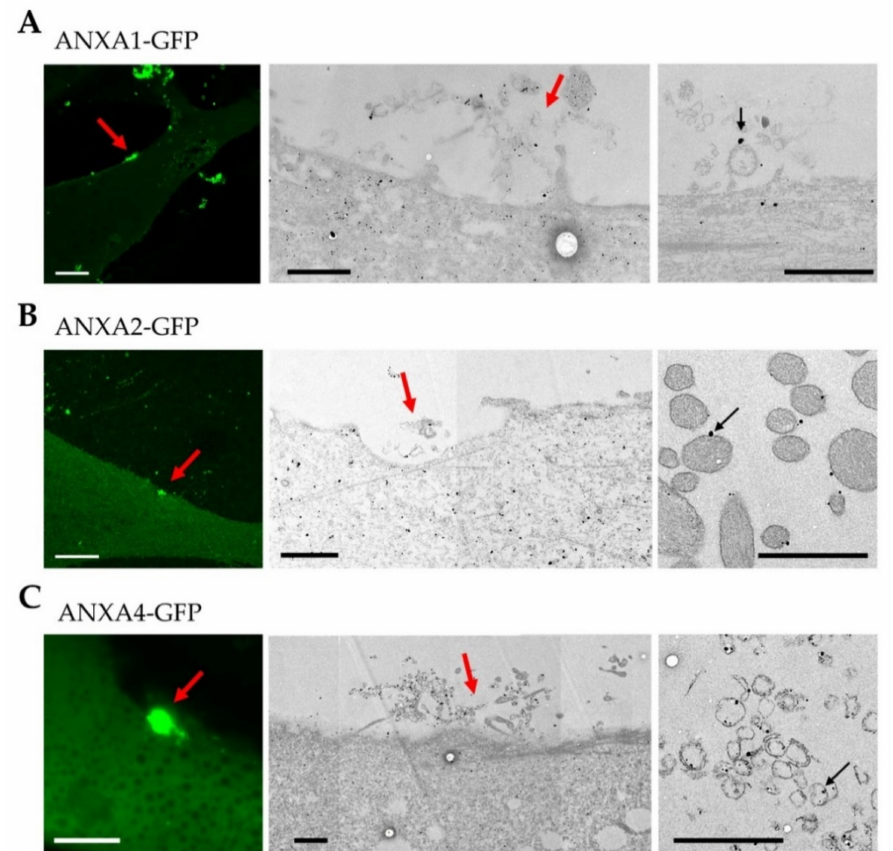
Figure 4. CLEM imaging of ANX in damaged LHCN myotubes. ANXA1-GFP ( A ), ANXA2-GFP ( B ), or ANXA4-GFP ( C ) expressing LHCN myotubes were damaged by laser ablation (red arrow) and immunostained for ANX using a secondary antibody coupled to gold nanoparticles (black particles). Fluorescence images obtained about 90 s after laser ablation are presented (left-hand image) together with TEM images (middle and right-hand images). Respective middle and right-hand images have been collected from different sections. Right-hand images show ANX (black particles) interacting with circular lipid structures (black arrow). Scale bar for fluorescence images: 10 µ m; for TEM: 1 µ